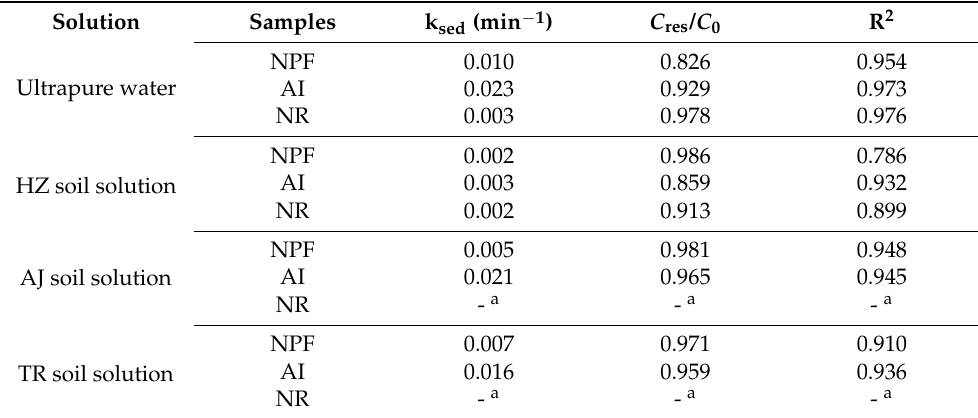
Table 1. The sedimentation parameters of NPF, AI, or NR in different solutions. Solution